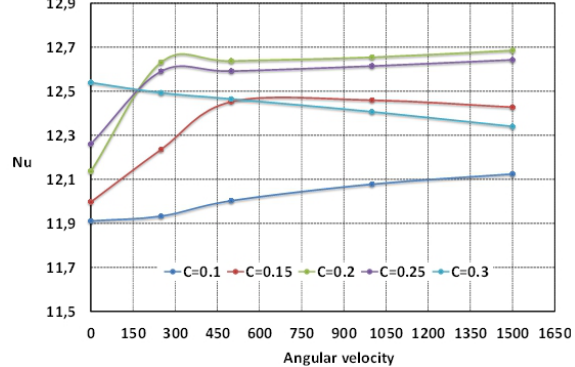
Fig. 12. Diversity of averaging Nu along heated surface with angular velocity; Ra = 10 6 and γ = 0 ◦ The maximum number can be found at an inclination angle of γ = 0 ◦ . As Ra increases, the average Nu within the hot wall goes up gradually. Since the rotational axis of the rotating cylinder influences the heat transfer process, the lowest average Nu is obtained at C = 0.1. Alternatively, maximum values can be obtained when C =